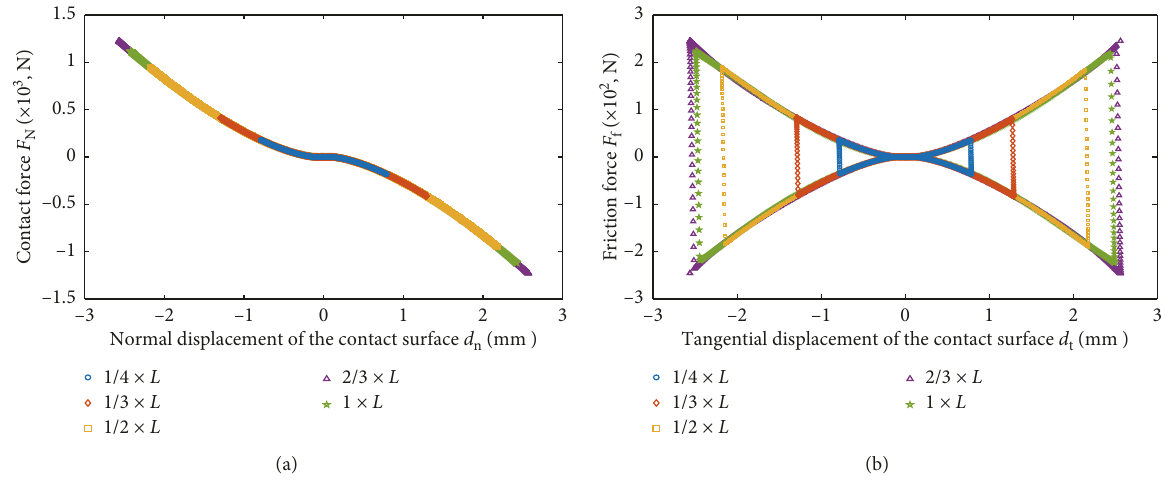
Figure 17: The curves of force at different shroud positions. (a) Contact forces. (b) Friction forces. 00.20.40.60.81.01.21.4